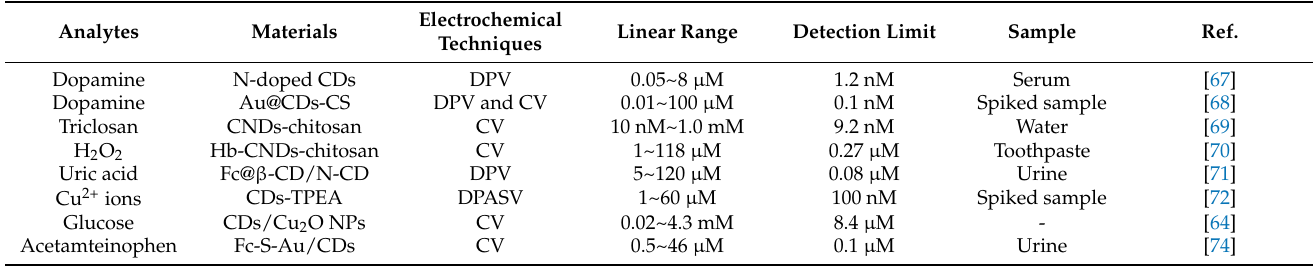
Table 1. Typical applications of electrochemical sensors based on CD materials associated with electrochemical techniques for the detection of different target